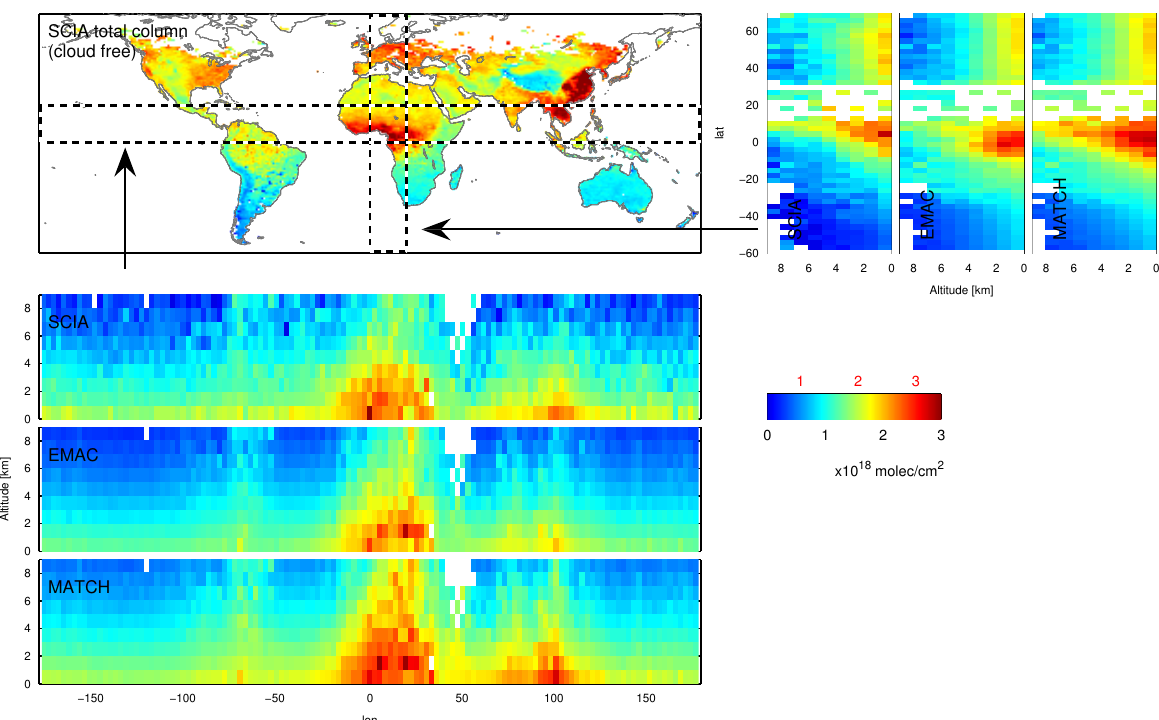
Fig. 12. Same as Fig. 11, but for meridional and zonal cross sections (January–March) over Africa.